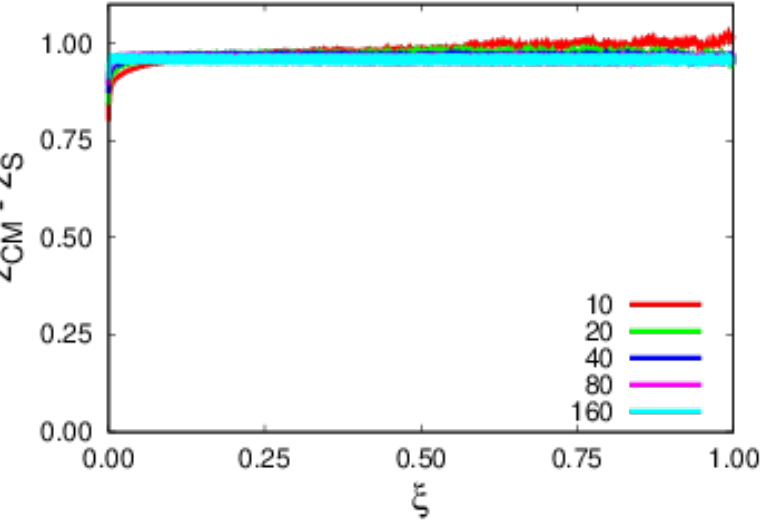
Figure 3. Plots of the position of the z -coordinate of the center of mass relative to the top layer substrate for different polymer sizes. In this and the following plots, the sizes and respective colors are N = 10 (red), 20 (green), 40 (blue), 80 (purple), and 160